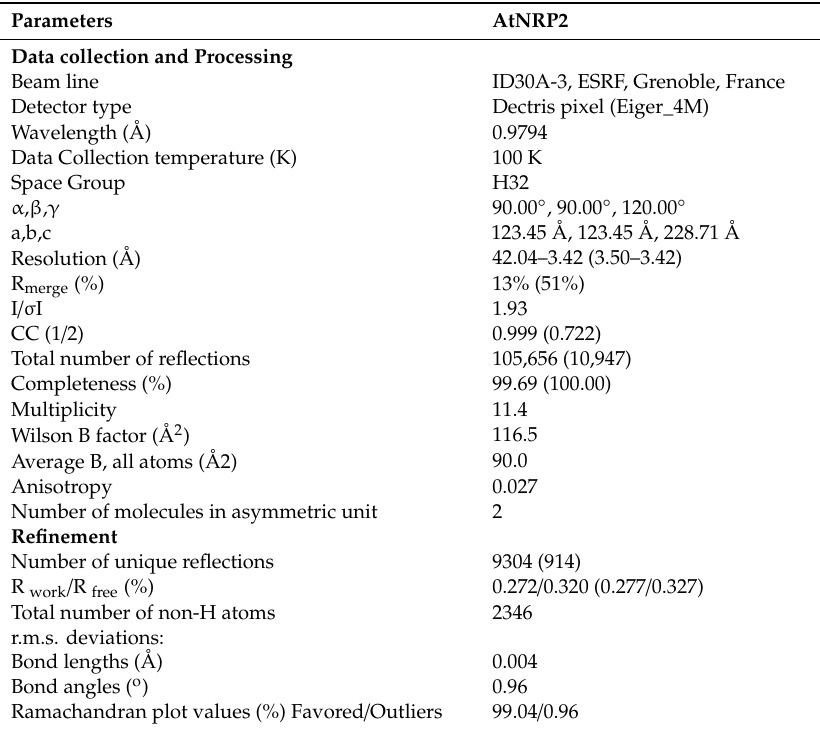
Table 1. Data processing and refinement statistics.